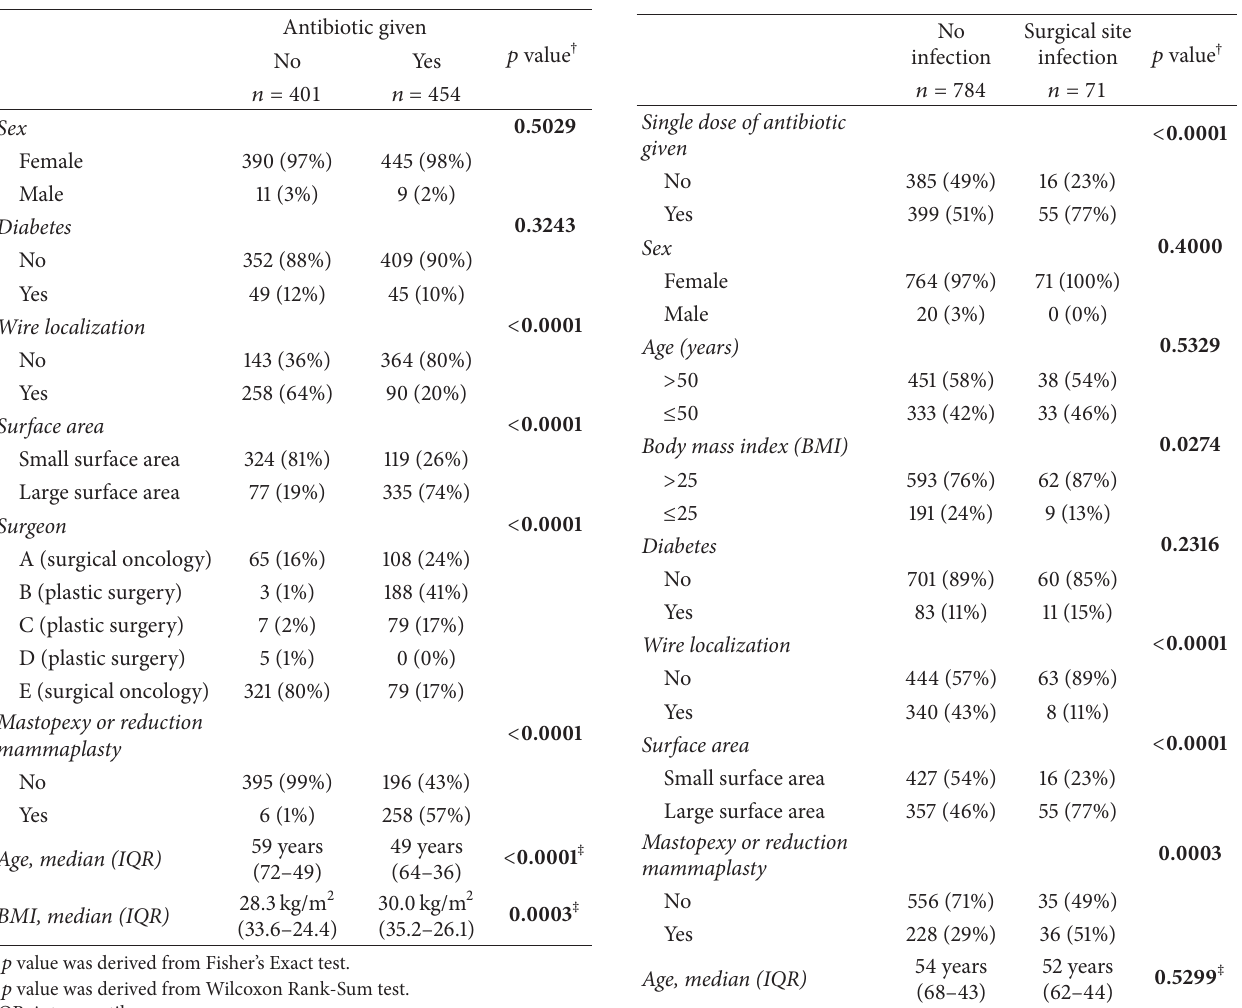
Table 1: Clinical characteristics of patients in relation to antibiotic administration.